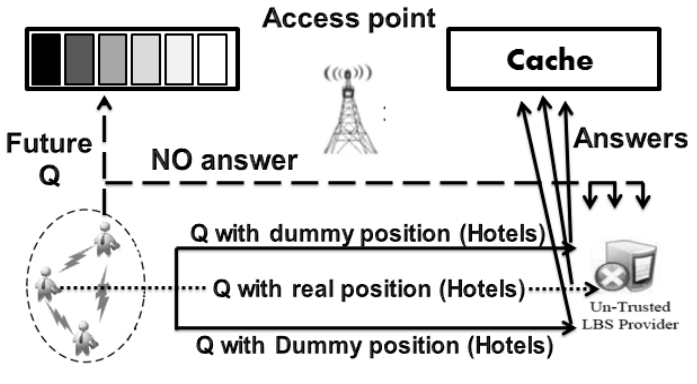
Figure 3. General scenario of cache-based approach.